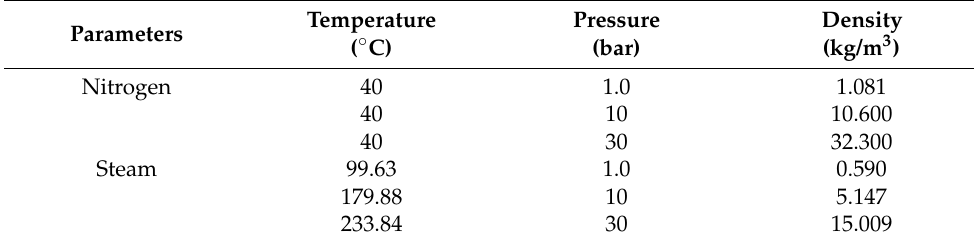
Table 5. Comparison of nitrogen gas and steam gas.